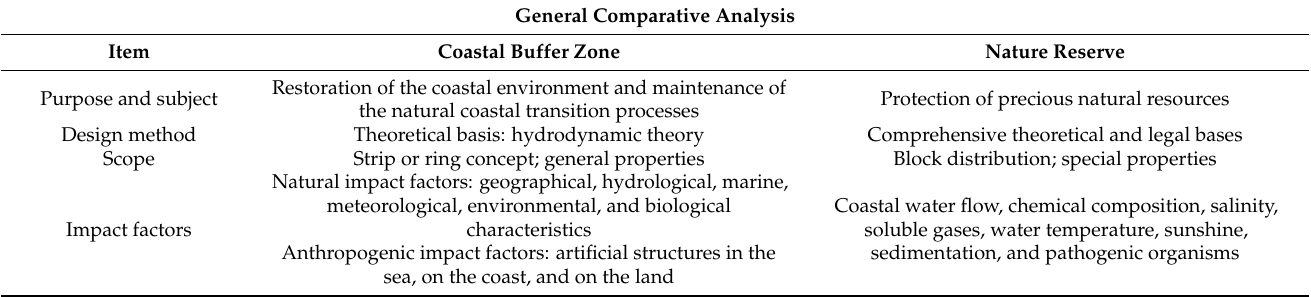
Figure 10. Zoning boundaries for various purposes in the coastal area (Howmeiliao Coast, Chiayi, Taiwan) [58]. Table 1. General comparative analysis of coastal buffer zone and nature reserve (Howmeiliao Coast, Chiayi, Taiwan) (based on Lan et al. [60]).